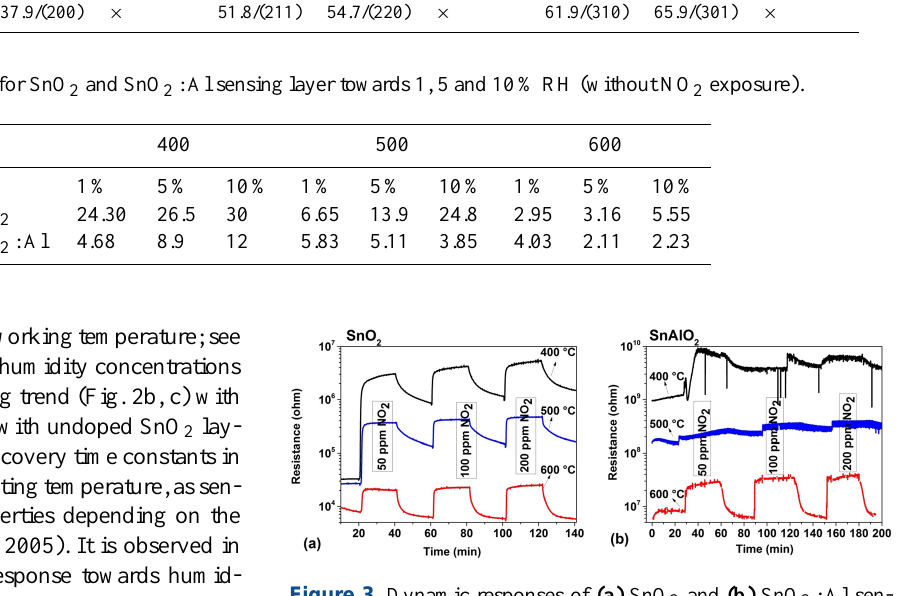
Figure 3. Dynamic responses of (a) SnO 2 and (b) SnO 2 :Al sen- sors when exposed to 50, 100 and 200ppm of NO 2 gas concen- trations in dry argon background, measured at T w = 400, 500 and 600 ◦